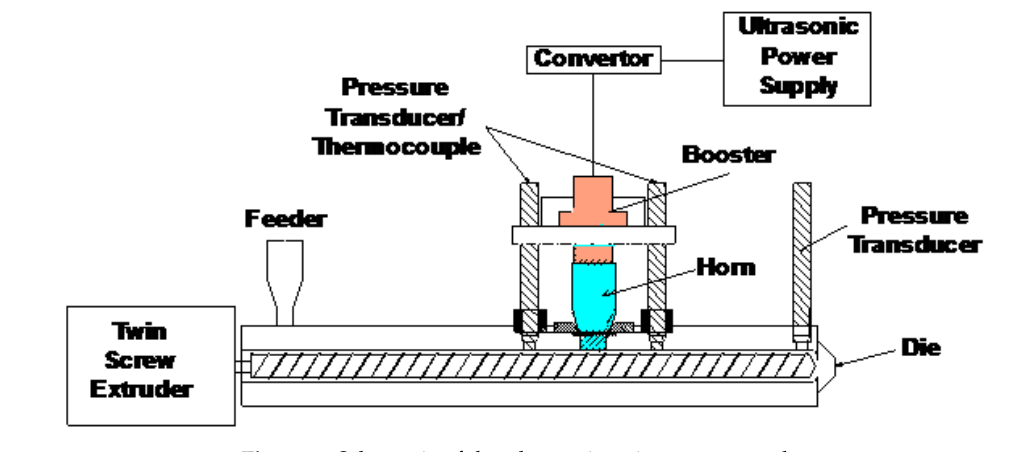
Figure 1. Schematic of the ultrasonic twin screw extruder.